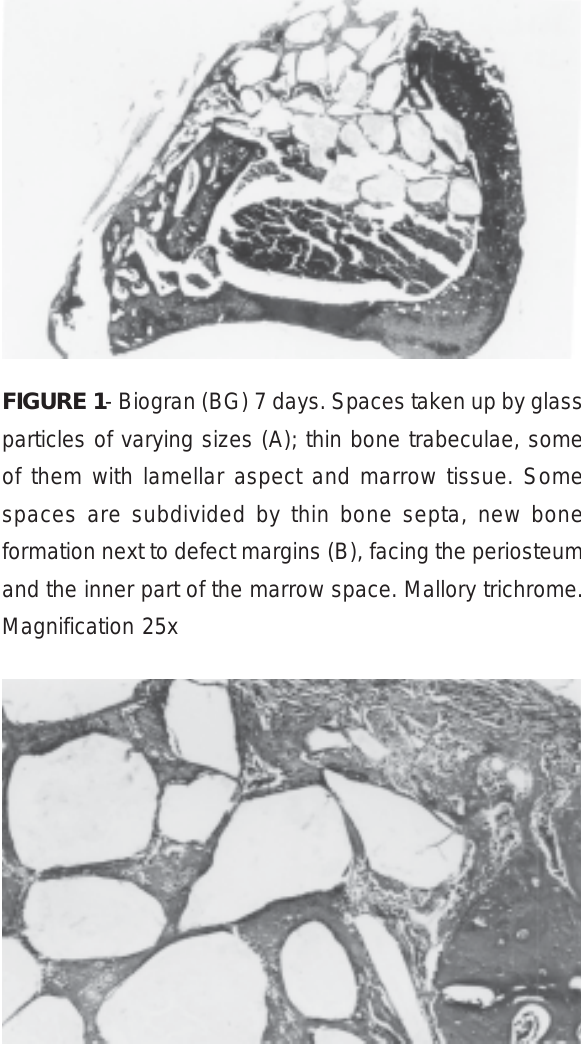
FIGURE 2 - Perioglass (PG) 7 days. Spaces filled with glass particles of varying sizes, encircling granulation tissue; immature bone trabeculae (A); scarce mononuclear inflammatory infiltrate. There are newly formed bone trabeculae next to the defect margins, surrounded by osteoblasts. Sub-periosteal new bone formation, next to the defect (B). HE. Magnification